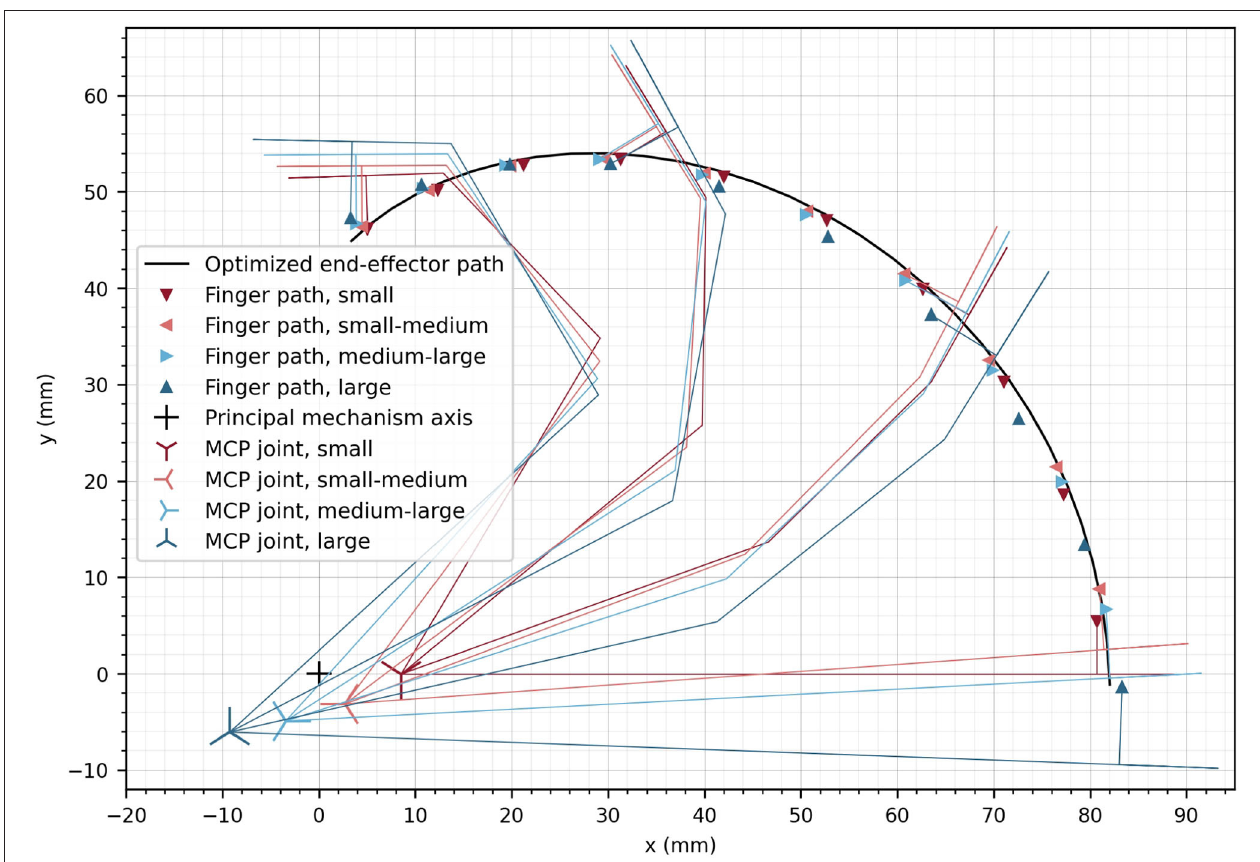
FIGURE 8 | Optimized end-effector path (solid line) and optimized positions of fingers at the discretized finger paths. The optimal location of the MCP joint is displayed for the different hand sizes as crosses. The small cross represents the location of the principle axis of rotation of the device. For a subset of the optimized finger positions, the finger segments are